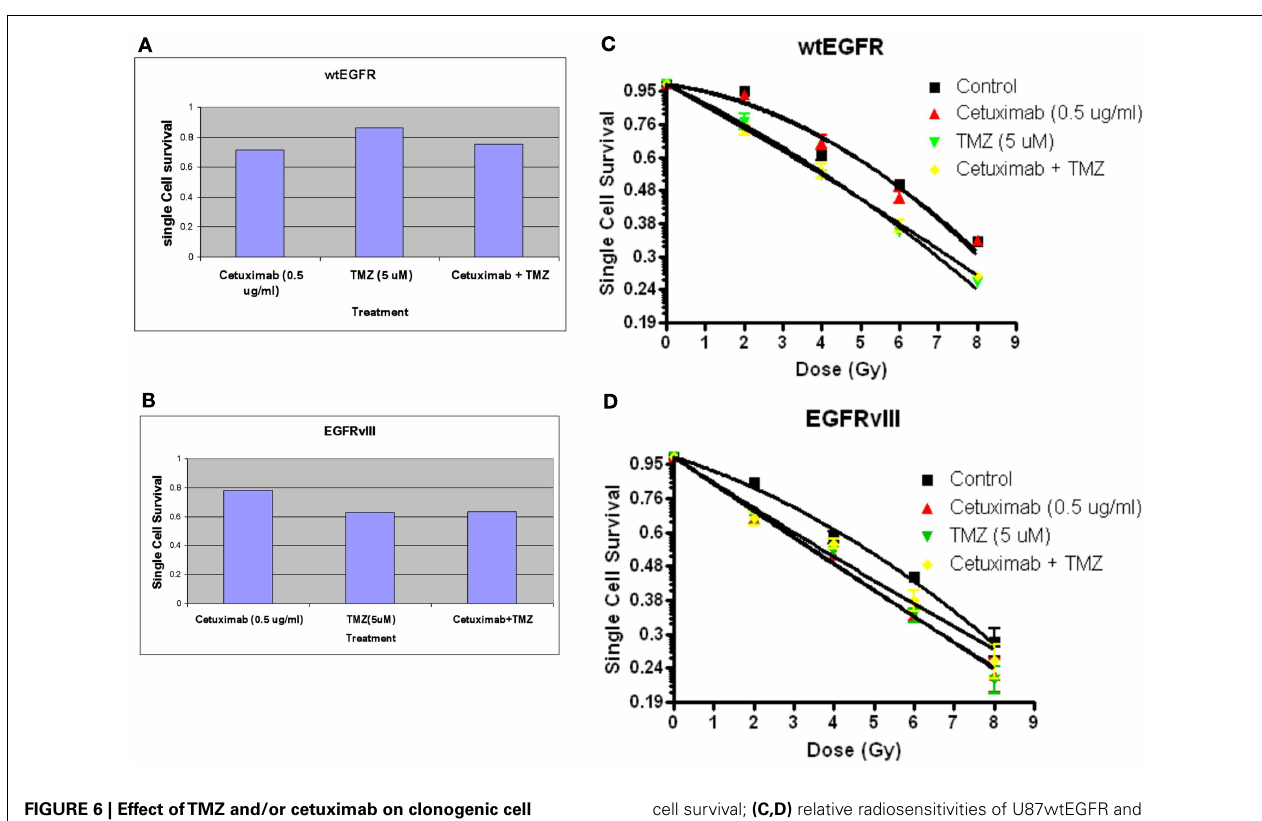
FIGURE 6 | Effect ofTMZ and/or cetuximab on clonogenic cell survival and radiosensitivity in U87EGFR vs. U87EGFRvIII cells. Cetuximab and/orTMZ were applied to exponentially growing cells 24h prior to irradiation. (A,B) effect ofTMZ and/or cetuximab on clonogenic